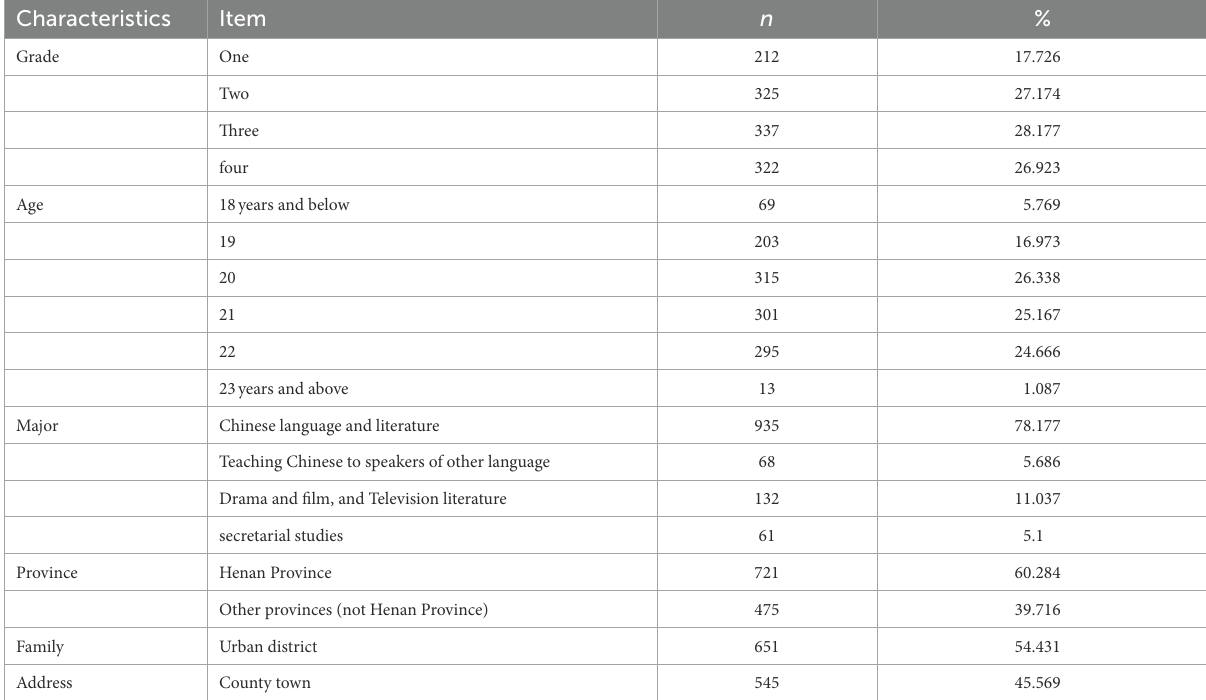
TABLE 1 Demographic information of sample ( N =